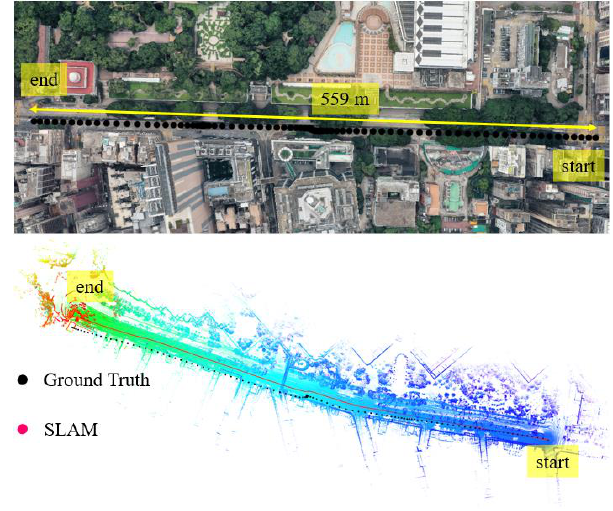
Figure 12. Experiment 4: the trajectory of NDT-based graph SLAM in a dense urban area with dense traffic condition. Top panel represents the snapshot in Google Maps. The black curve indicates the ground truth of the vehicle’s trajectory. The bottom panel indicates the generated points map and trajectory from SLAM.